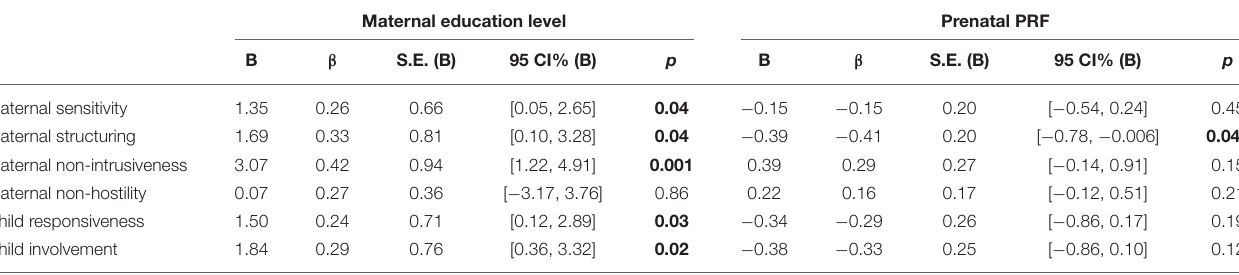
TABLE 7 | Associations between maternal prenatal PRF and change in maternal and child EA from 4 to 12 months. Maternal education level Prenatal PRF